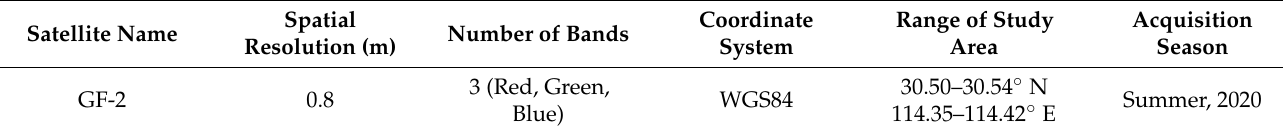
Table 1. The parameters of the GF-2 used in this